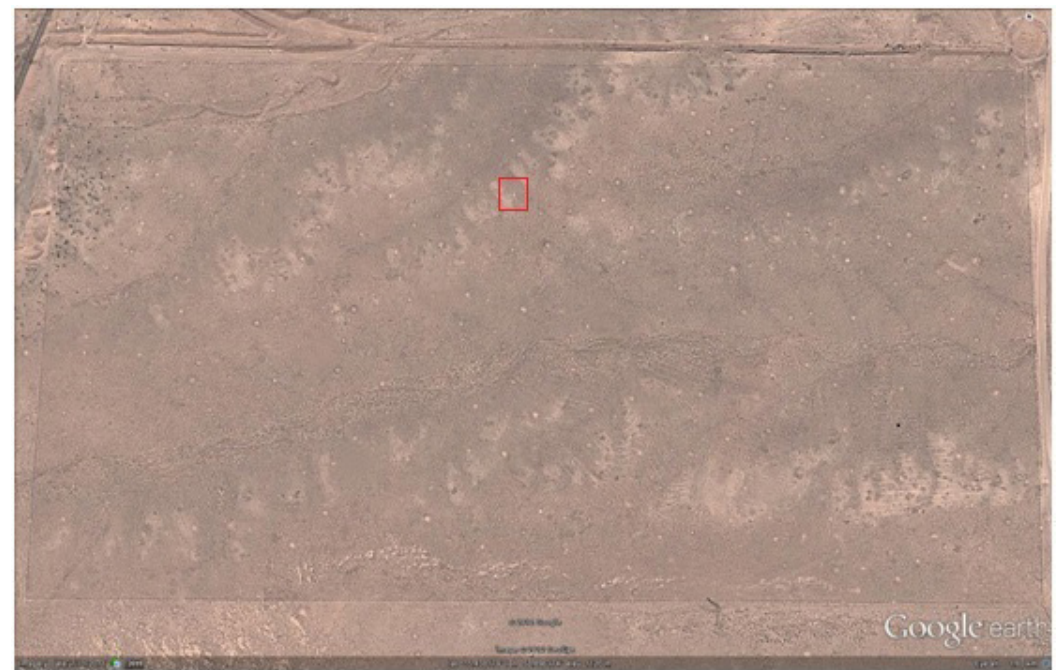
Fig 1. Location of the study area at Roodshoor, Saveh, Iran, showing location of Messor cf. intermedius ant colonies (light circles like the one in the red square). (Photo courtesy of Google earth).